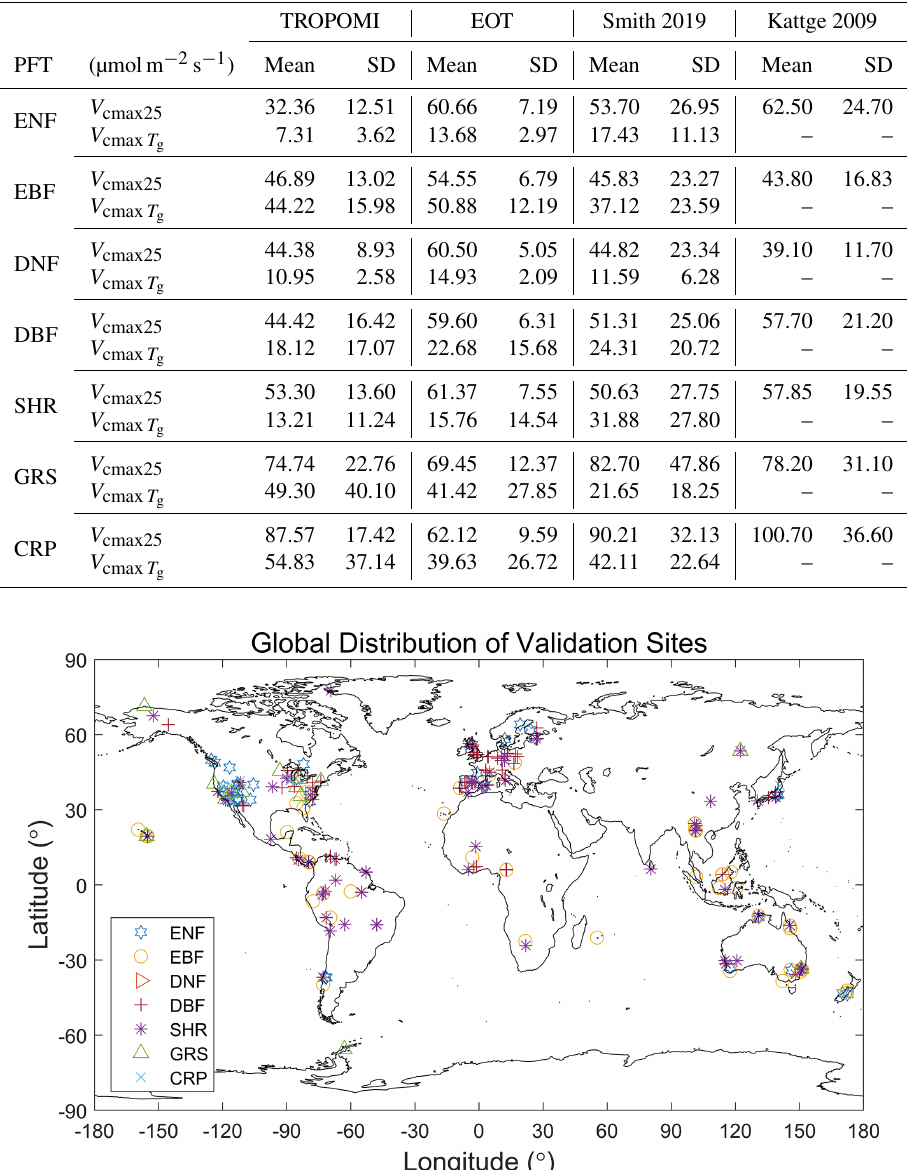
Table 2. Mean and standard deviation (SD) of V cmax at the growing temperature ( V cmax T plant functional types (PFTs) calculated from the TROPOMI and ecological optimality theory (EOT) products in comparison with two ground-based databases (Smith et al., 2019; Kattge et al., 2009).